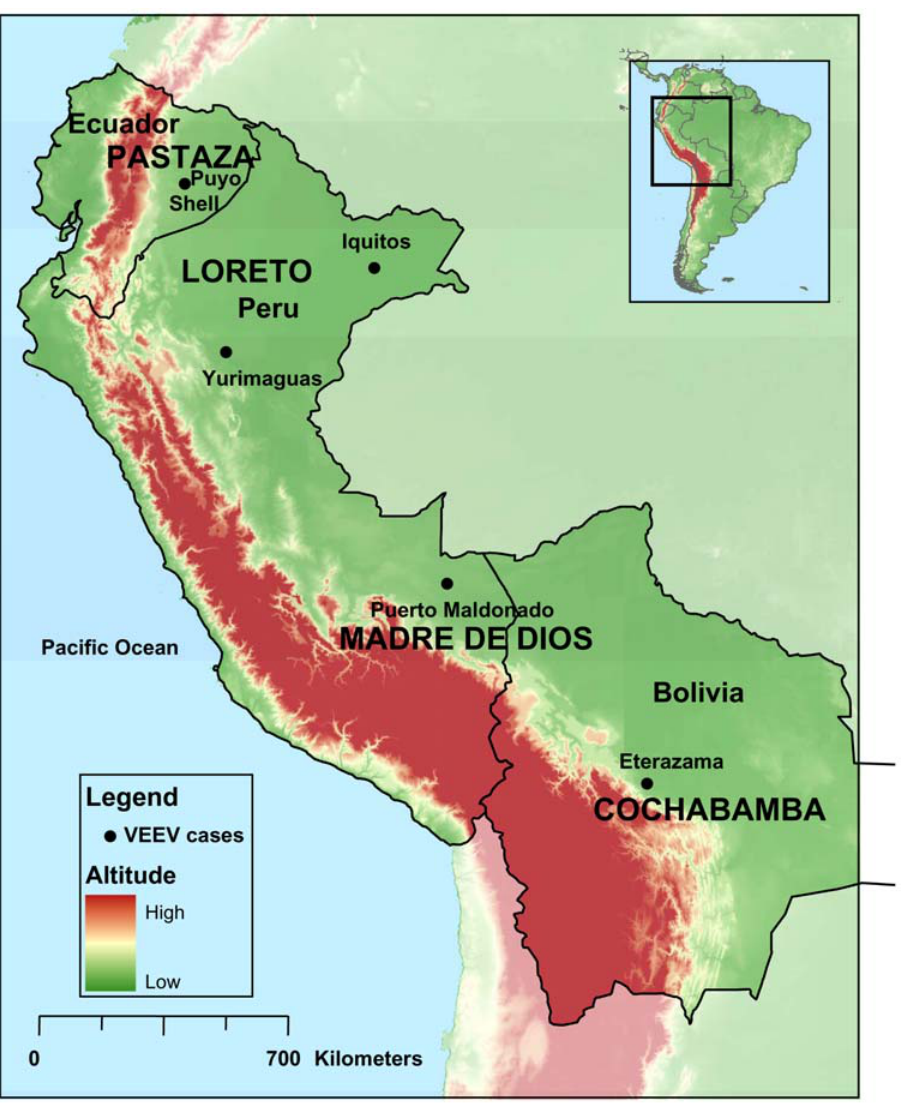
Figure 1. Geographic distribution of the sites in Ecuador, Peru, and Bolivia with confirmed cases of VEE.